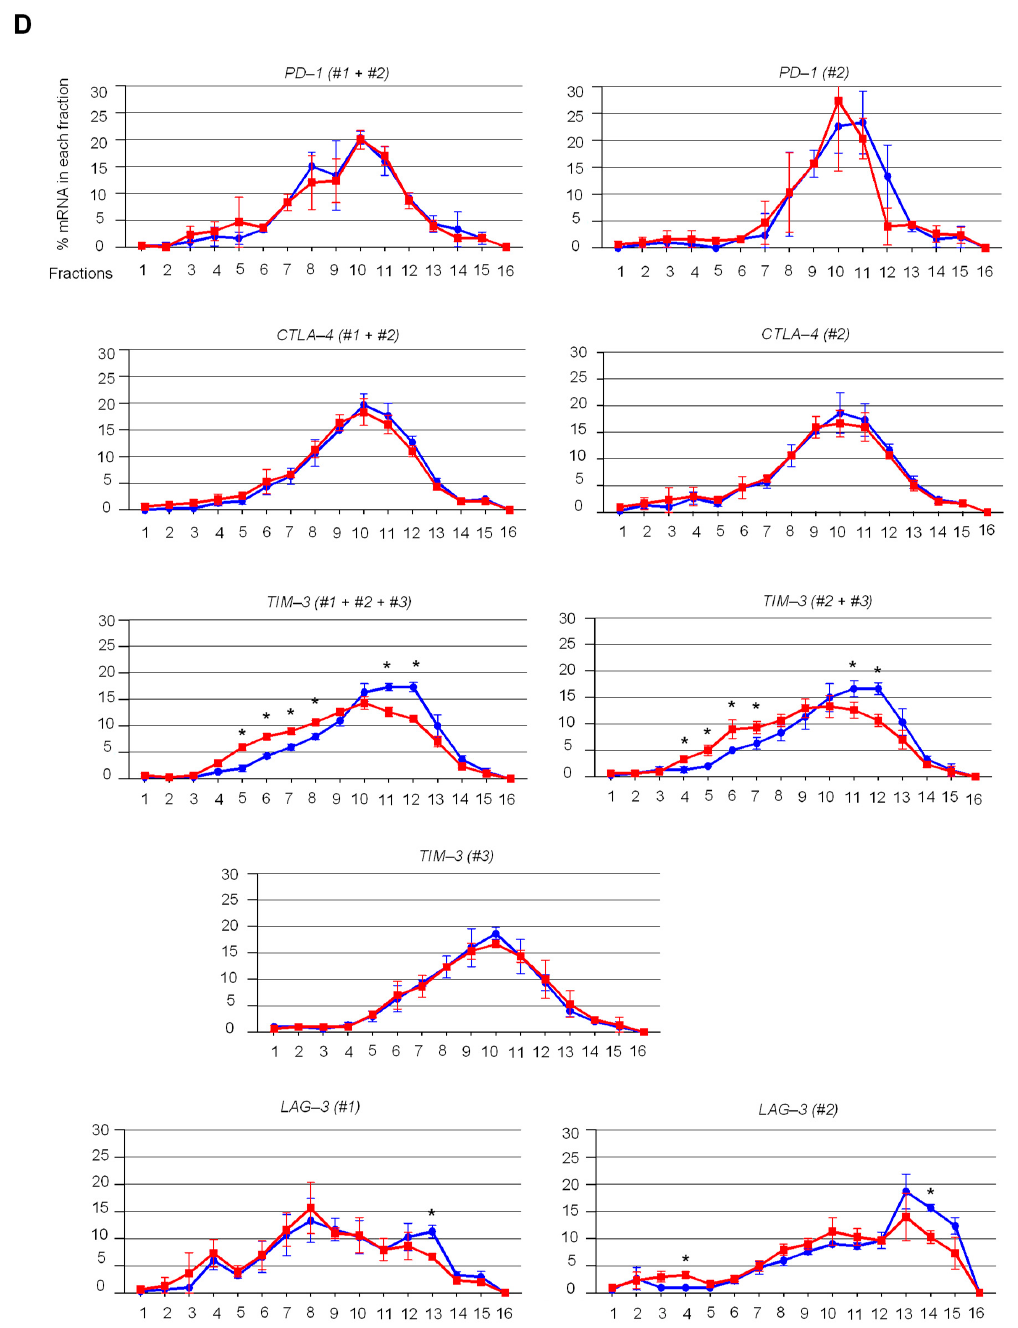
Figure 3 Figure 3. eIF4A inhibition regulates the translation of mRNAs encoding key immune checkpoint proteins such as TIM-3 and LAG-3, but not PD-1 and CTLA-4, in activated T cells. ( A ) polysome profiles of T cells stimulated for 72 h and treated with silvestrol (10 nM or 30 nM) for 2 h. One representative profile from three independent experiments is shown. ( B ) Percentage of transcripts for each STAT1 APA isoform in each polysomal fraction obtained by sucrose-gradient ultracentrifugation of T cells was quantified by RT-qPCR ( n = 3). p -values were calculated using two-tailed unpaired t -test (* p ≤ 0.05); ( C ) primer design for immune checkpoint gene mRNA isoforms; ( D ) percentage of transcripts for each APA isoform in each polysomal fraction obtained by sucrose-gradient ultra- centrifugation was quantified by RT-qPCR ( n = 3). An asterisk (*) was inserted for each fraction to indicate a statistically significant difference ( p <